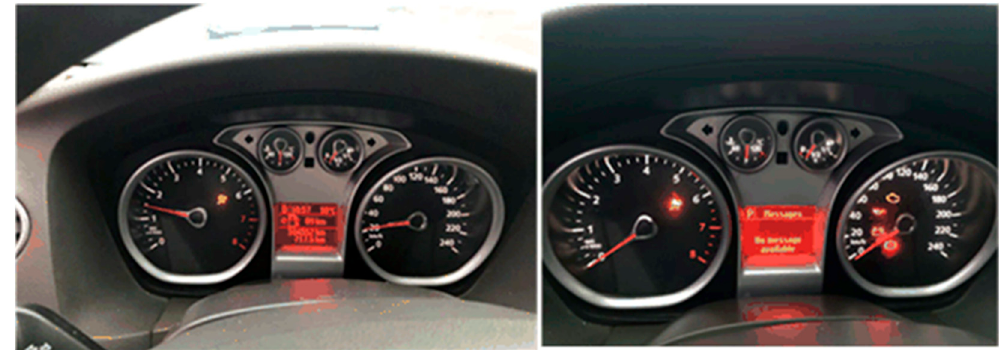
Figure 6. Fuzzy attack against the Ford vehicle.